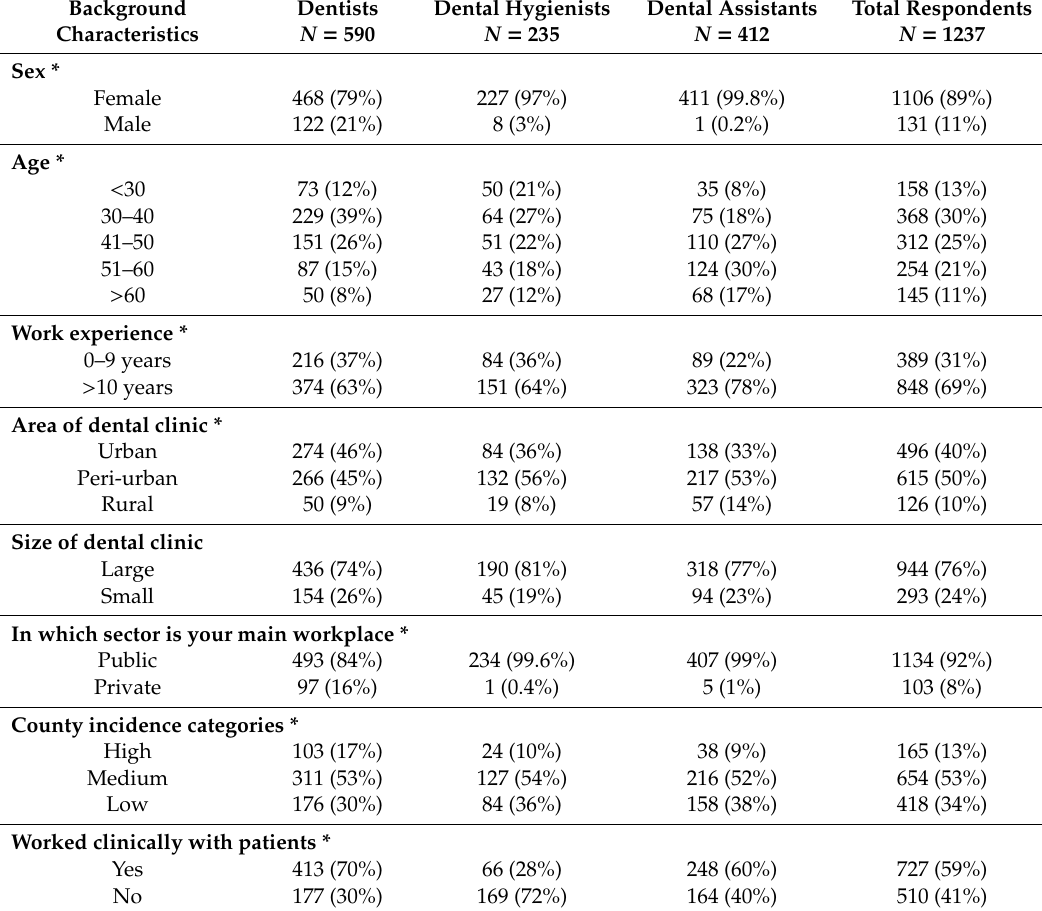
Table 1. Background characteristics of study sample stratified by